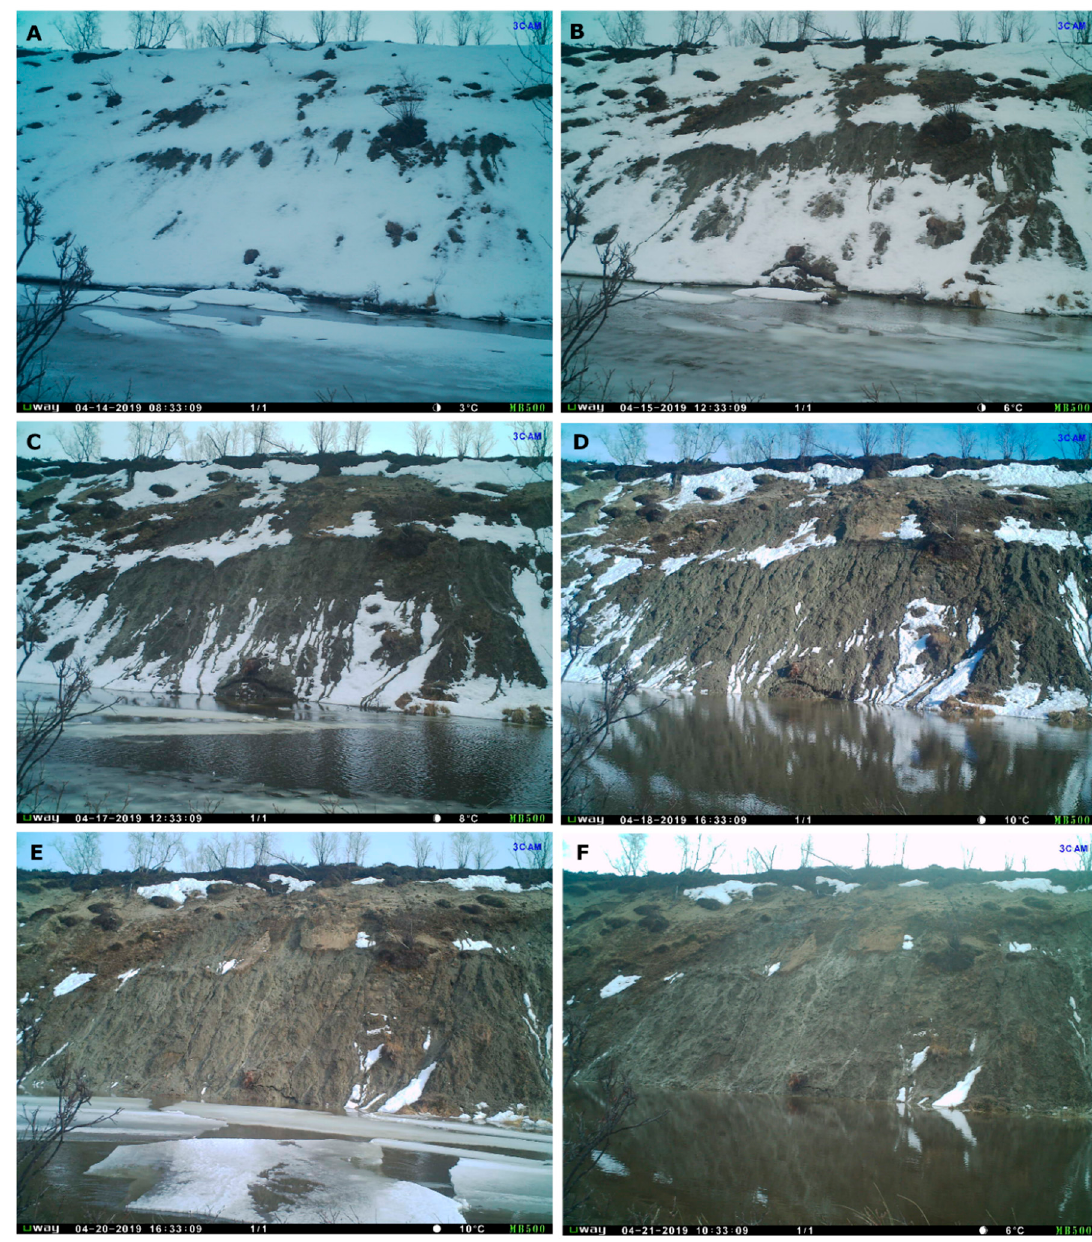
Figure 9. The thawing during spring 2019 as an example of a combined thermal and mechanical ice break-up. The camera was at the bank location. There had been similar mid-winter melting occasions in the 2016 spring. However, in this figure, only the melting and break-up times are presented to show the difference of this location to the HOBO location (Figure 8), where the processes were more mechanical than in this upstream location. ( A ) 14 April 2019: This is the first time step when there is a clearly continuous flowing water area at the outer bank. ( B ) 15 April 2019: This is the time step when both the water level and the ice cover have started to rise (difference to the previous 10:33 time step’s water level). Thermal decay of the ice cover is taking place. ( C ) 17 April 2019: a mechanical ice break-up has happened between this 12:33 and previous 10:33 time step. The water level has kept rising gradually between 15–17 April 2019. ( D ) 18 April 2019: there is no more ice in the river (no rafts, nor rim ice). The water level is still rising. ( E ) 20 April 2019: big ice rafts appear in the picture, as they have been transported form the upstream. ( F ) 21 April 2019: ice rafts are all gone, and the ice melt has ended. The water level kept rising after the picture was taken.